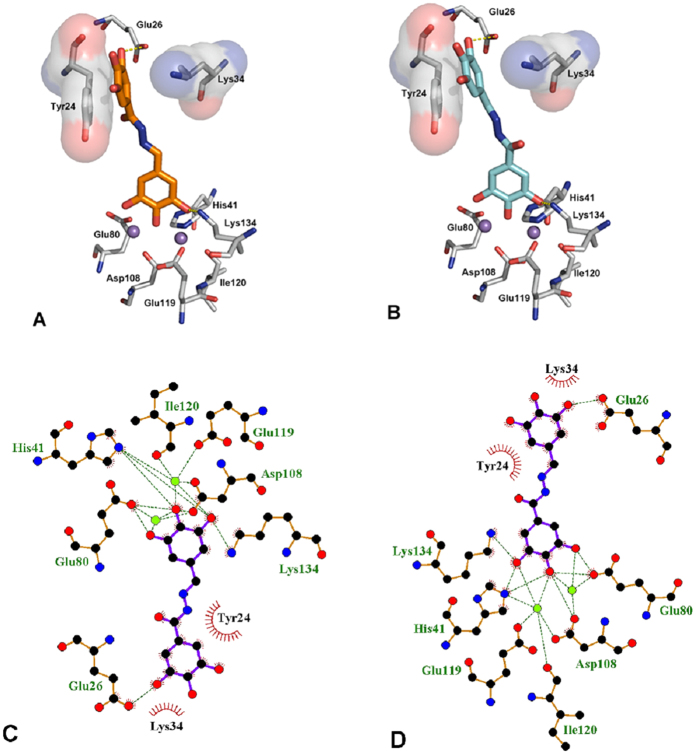
First (A) and second (B) GOLD cluster docked solutions of compound 23 (orange and cyan, respectively) in complex with PA endonuclease. Key residues of the pocket are presented using PyMOL [ http://www.pymol.org] and LIGPLUS [Laskowski, R. A.; Swindells, M. B. Journal of chemical information and modeling
2011,
51, 2778]. Hydrogen bonds are illustrated by dotted lines, while the divalent metal ions are shown as purple spheres. Schematic drawings of the interactions of the first (C) and second (D) GOLD cluster docked solutions generated using LIGPLUS. Dashed lines are hydrogen bonds and ‘eyelashes’ show residues involved in hydrophobic interactions.